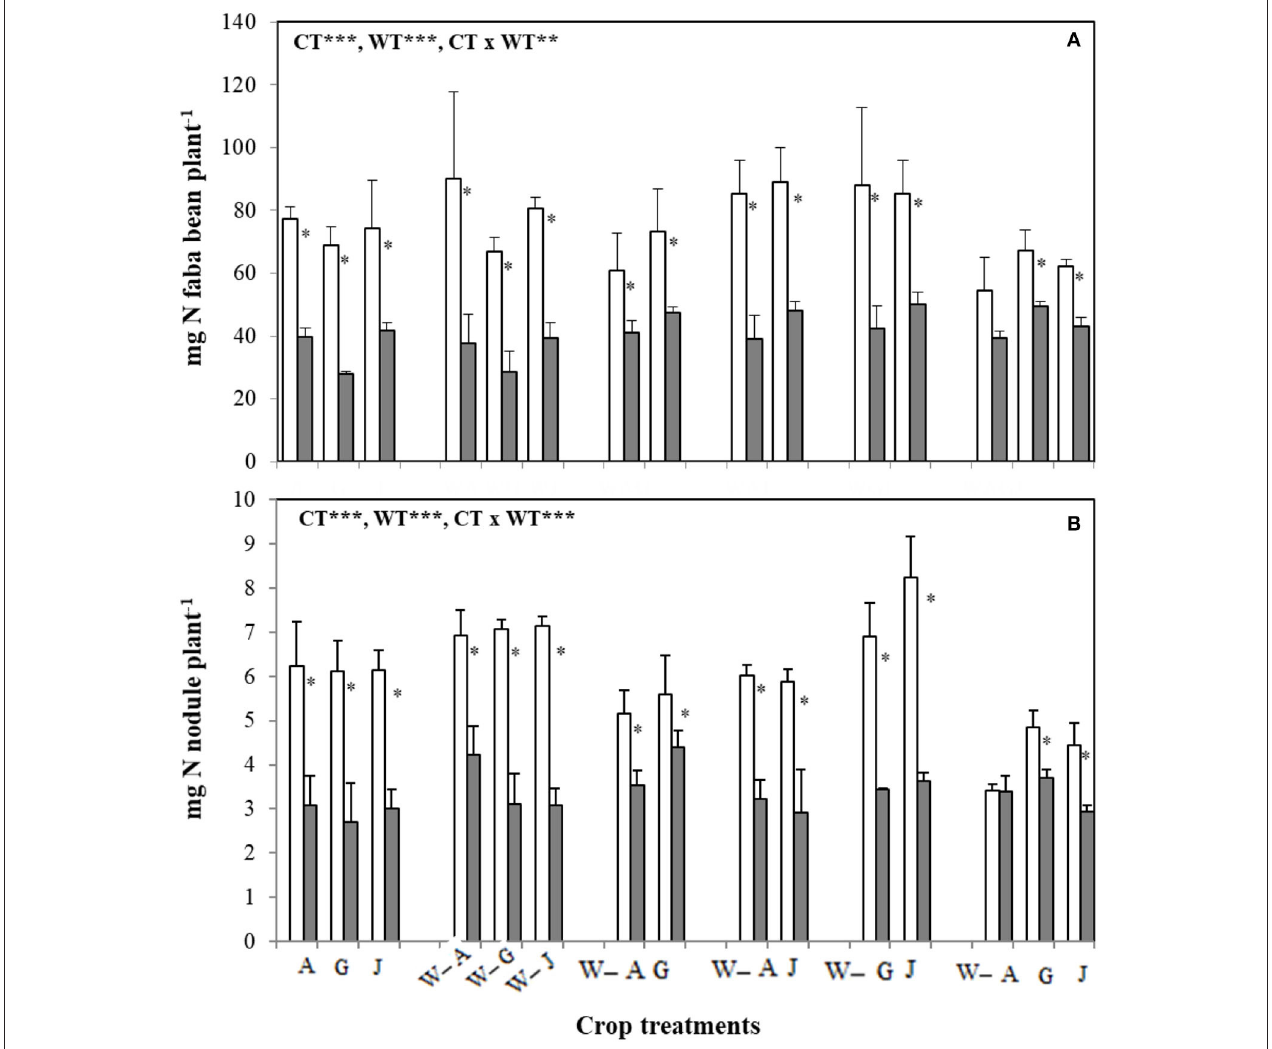
FIGURE 6 | Nitrogen content in shoots (A) and nodules (B) of the three faba bean varieties, A, G, and J, grown as sole crops (A, G, and J) or intercropped with W under adequate watering (80% field capacity; open bars) vs. water-stressed (30% field capacity, filled bars) conditions. Data are means and SE of three replicates harvested at 49 days post-transplantation. An asterisk * denotes a significant difference at p <